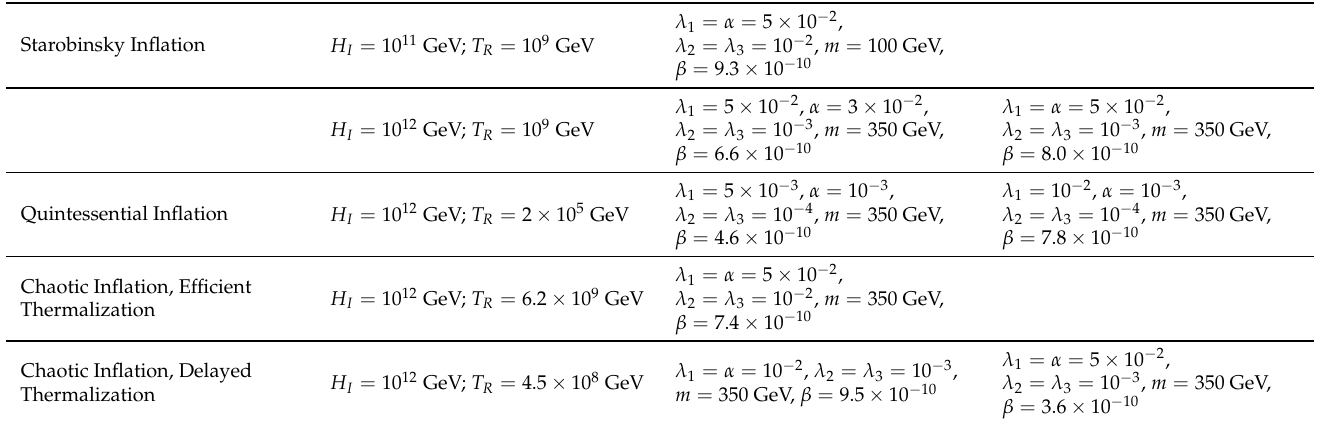
Table 1. Successful production of the observed baryon asymmetry value β obs for particular sets of SCF model parameters in different inflationary